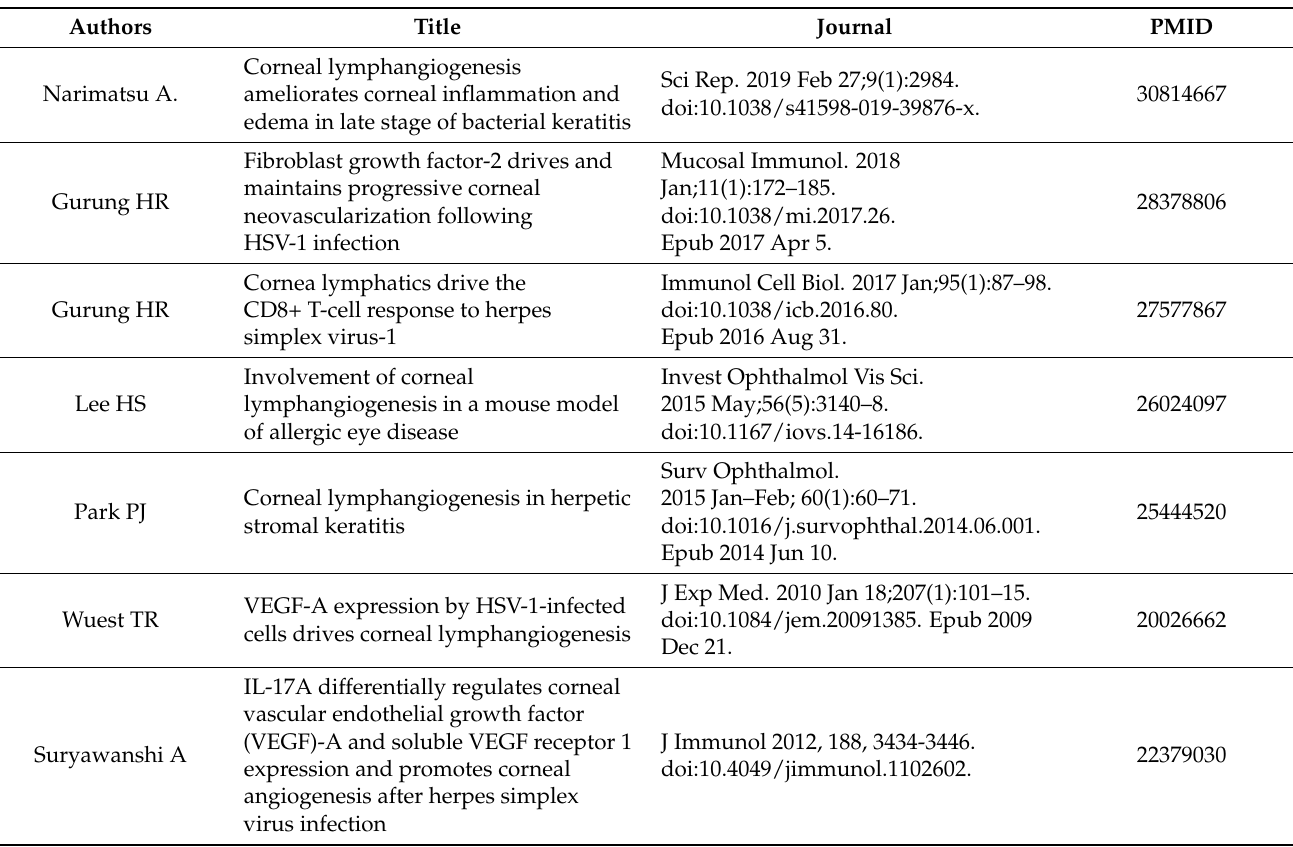
Table 3. Recent literature on keratitis, ocular allergy, and